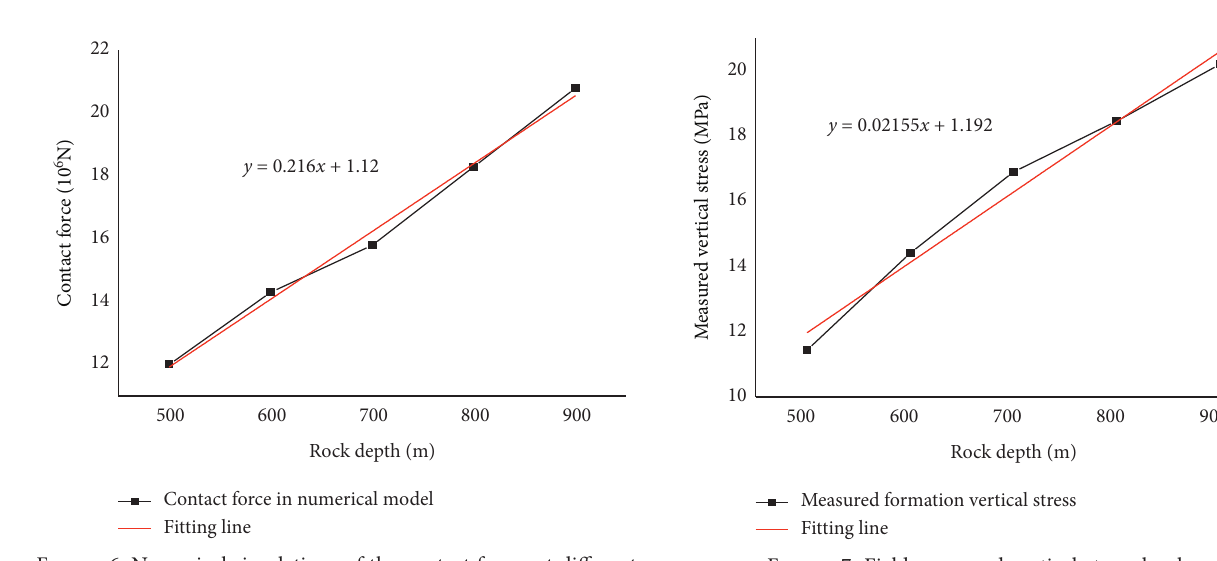
Figure 7: Field measured vertical stress